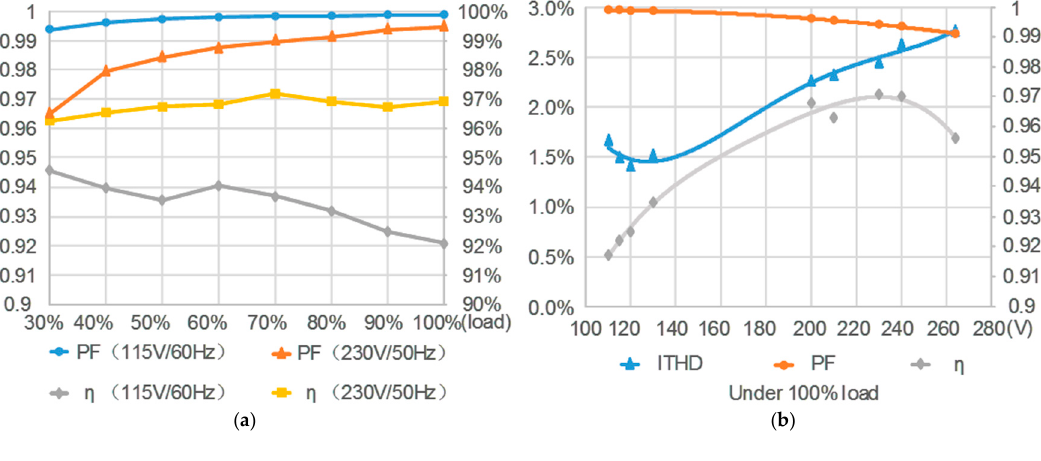
Figure 8. Experiment results. ( a ) State–state waveforms; ( b ) output voltage ripple; ( c ) dynamic waveforms with and without load; ( d ) detail waveforms at load step